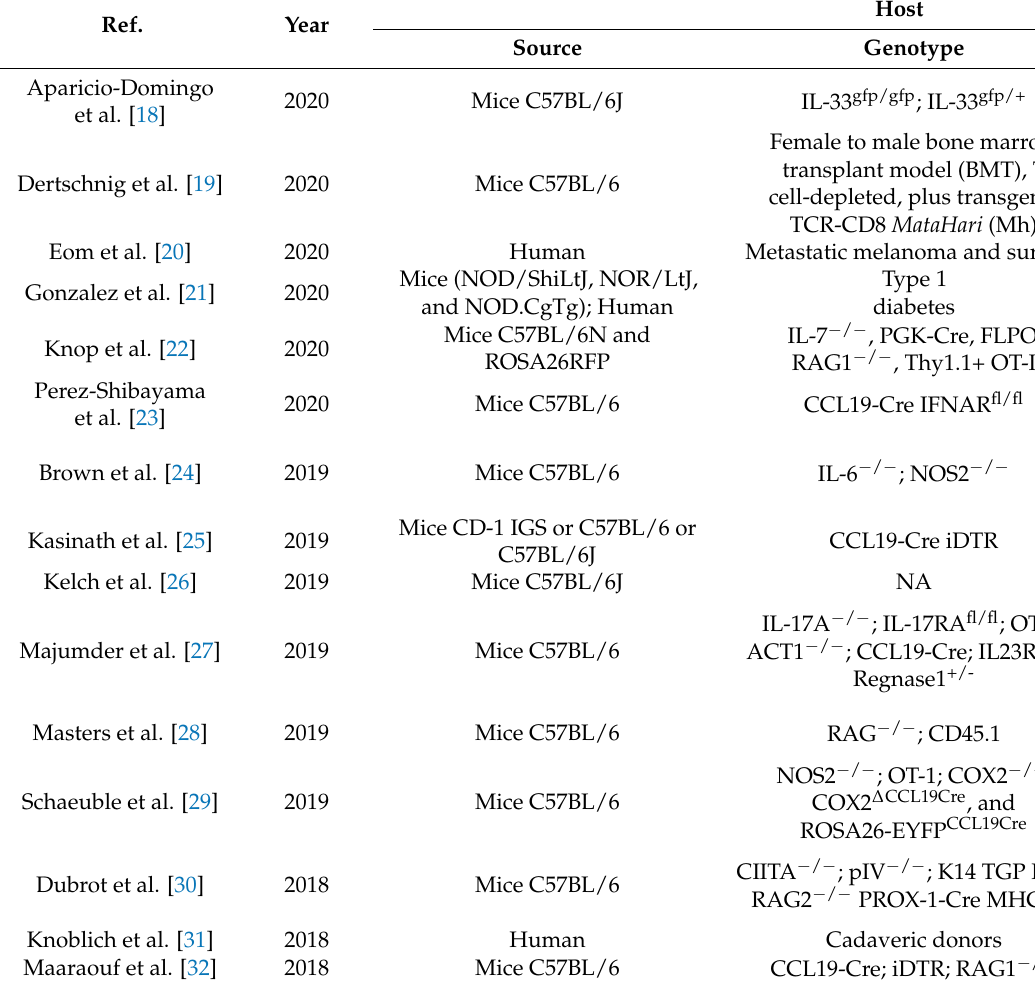
Table 1. Characteristics of hosts and the interventions that they received before in vitro analysis.